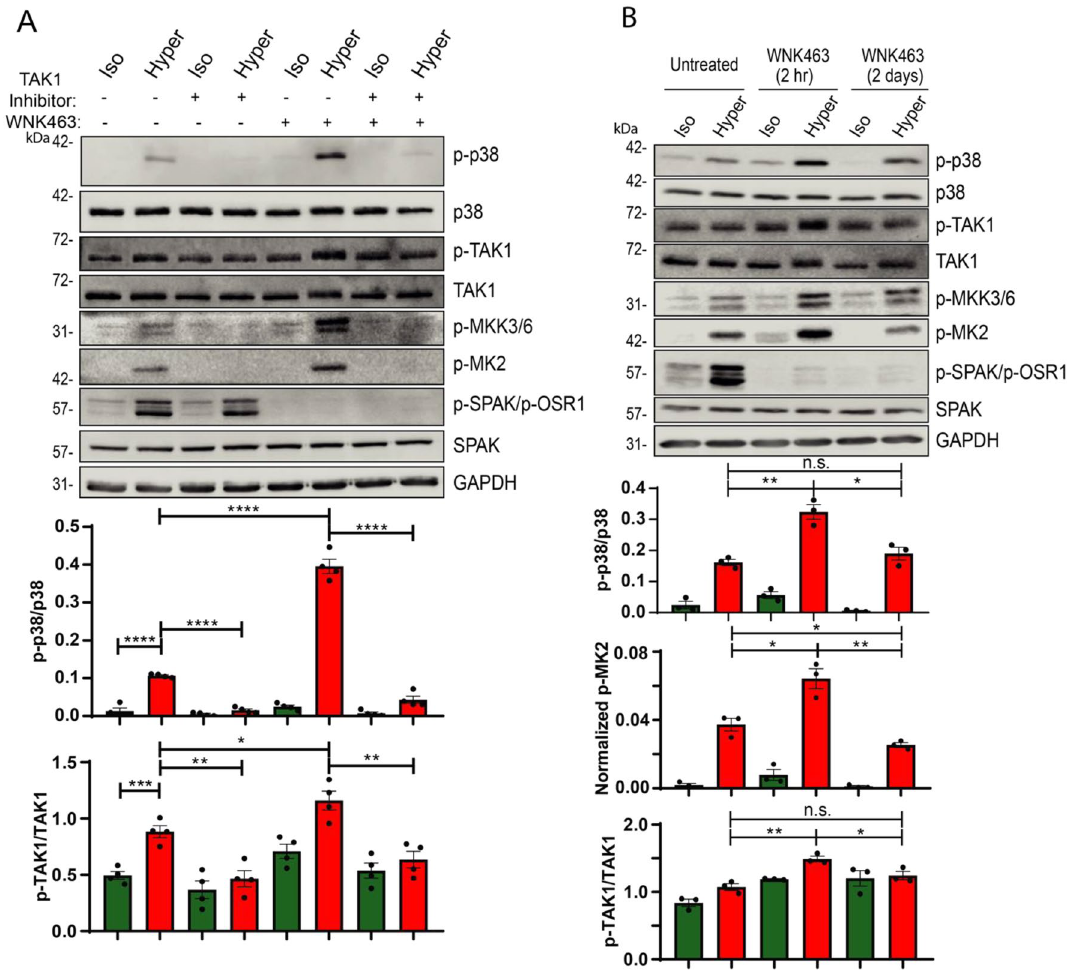
Figure 4. WNK kinases inhibit the p38 pathway by suppressing TAK1. ( A ) HeLa cells were treated (or not) with 1 μM 5Z-7-Oxozeanol (TAK1 inhibitor) for 1 h or 10 μM WNK463 (pan-WNK inhibitor) for 2 h, or both inhibitors, followed by incubation with iso- or hyper- osmotic NaCl solutions for 15 min. ( B ) HeLa cells were treated (or not) with 10 μM WNK463 for 2 h or 2 days followed by incubation with either iso- or hyper-osmotic NaCl solutions for 15 min. Quantification of active p38 (p-p38), TAK1 (p-TAK1) or MK2 (p-MK2) is depicted below their respective blots. All data are mean ± s.e.m, N ≥ 3 independent experiments. Statistics as described